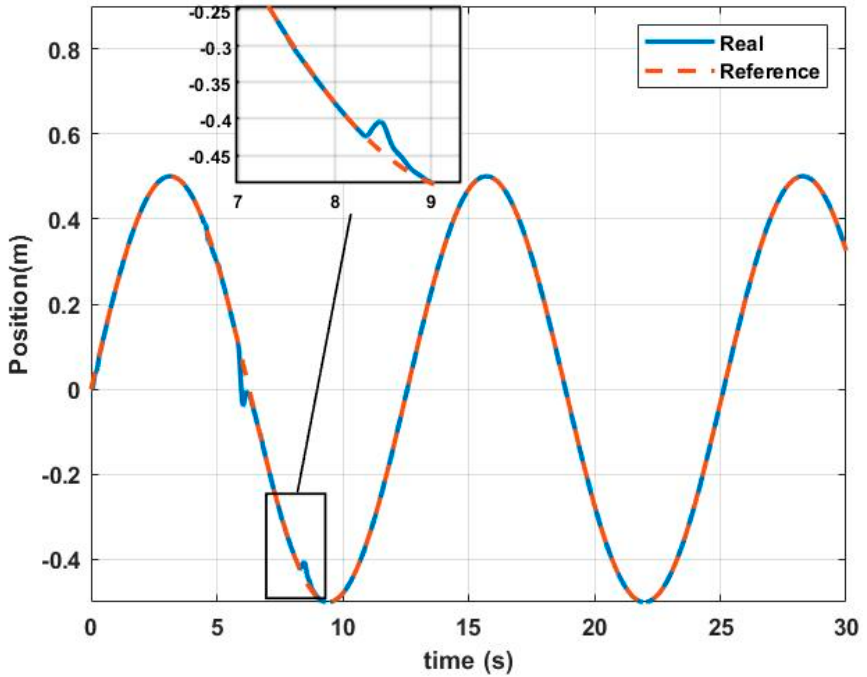
Figure 16. Y ( Blue Solid line ) real vs. Y ( Red dotted line ) desired with Figure 16. Y ( 𝐵𝑙𝑢𝑒 𝑆𝑜𝑙𝑖𝑑 𝑙𝑖𝑛𝑒 ) real vs. Y (𝑅𝑒𝑑 𝑑𝑜𝑡𝑡𝑒𝑑 𝑙𝑖𝑛𝑒) desired with perturbance.